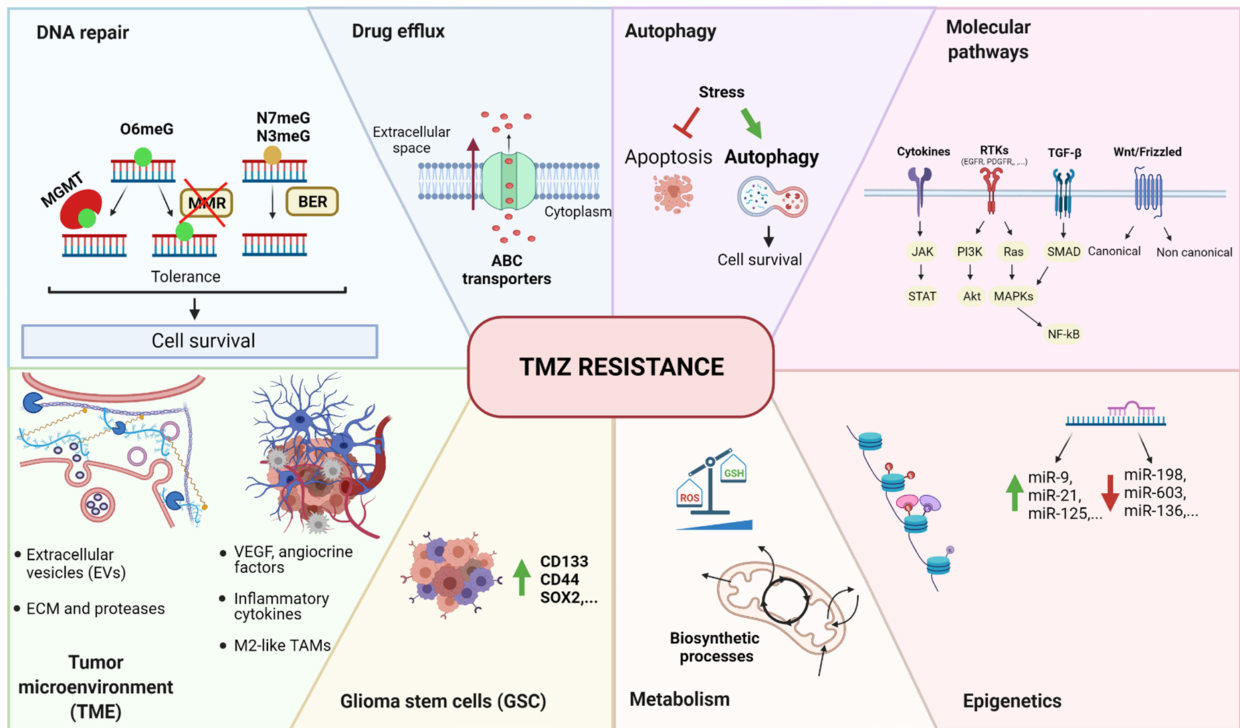
Figure 1. Summary of temozolomide resistance mechanisms in GBM. The main mecha- nisms can be grouped as follows: DNA repair, drug efflux, autophagy, molecular path- ways, epigenetics, metabolism, glioma stem cells (GSC), and tumor microenvironment (TME).